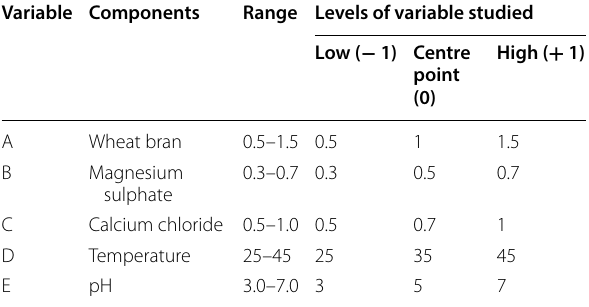
Table 1 Experimental range and levels of the independent variables for the CCD based RSM experiment Variable